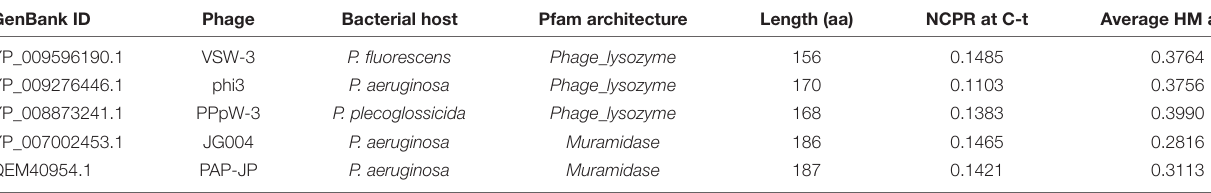
TABLE 2 | Final enzybiotic candidates after the screening process. GenBank